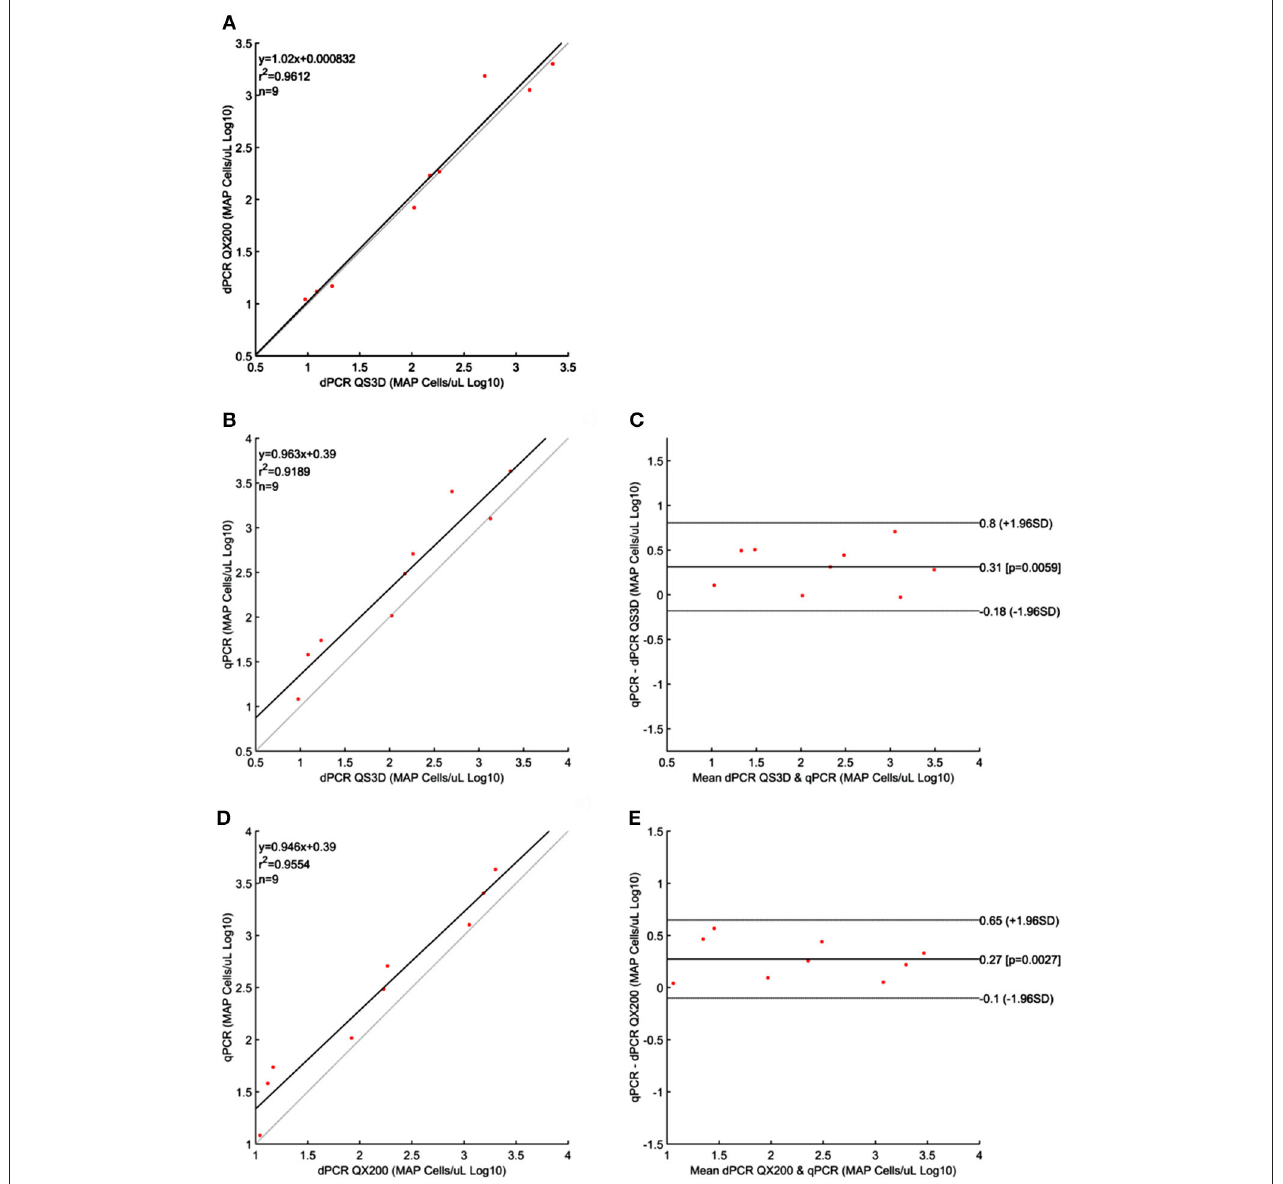
FIGURE 2 | Linear regressions and Bland and Altman analyses of Mycobacterium avium subsp. paratuberculosis (MAP) cells in unknown samples obtained by dPCRs (QuantStudio 3D and QX200) and qPCR. (A) Linear regression between the two dPCRs; (B) Linear regression of dPCR QuantStudio 3D and qPCR; (C) Bland and Altman analysis of dPCR QuantStudio 3D and qPCR; (D) Linear regression of dPCR QX200 and qPCR; (E) Bland and Altman analysis of dPCR QX200 and qPCR. Bland and Altman analysis between the two dPCRs platform was not possible because the differences were not normally distributed. Data were reported as Log 10 cells per µ L. The gray lines in linear regression plots represent the ideal regression